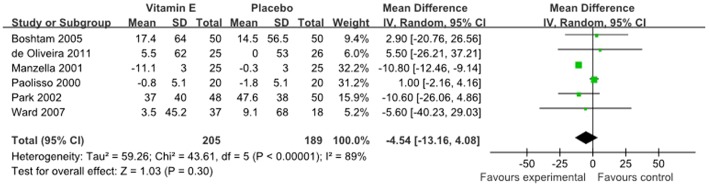
Forest plot of randomised controlled trials investigate the effect of vitamin E supplementation on fasting insulin.